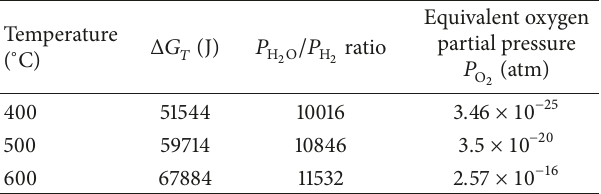
Table 2: Thermodynamic data of oxidation reaction (6) at different